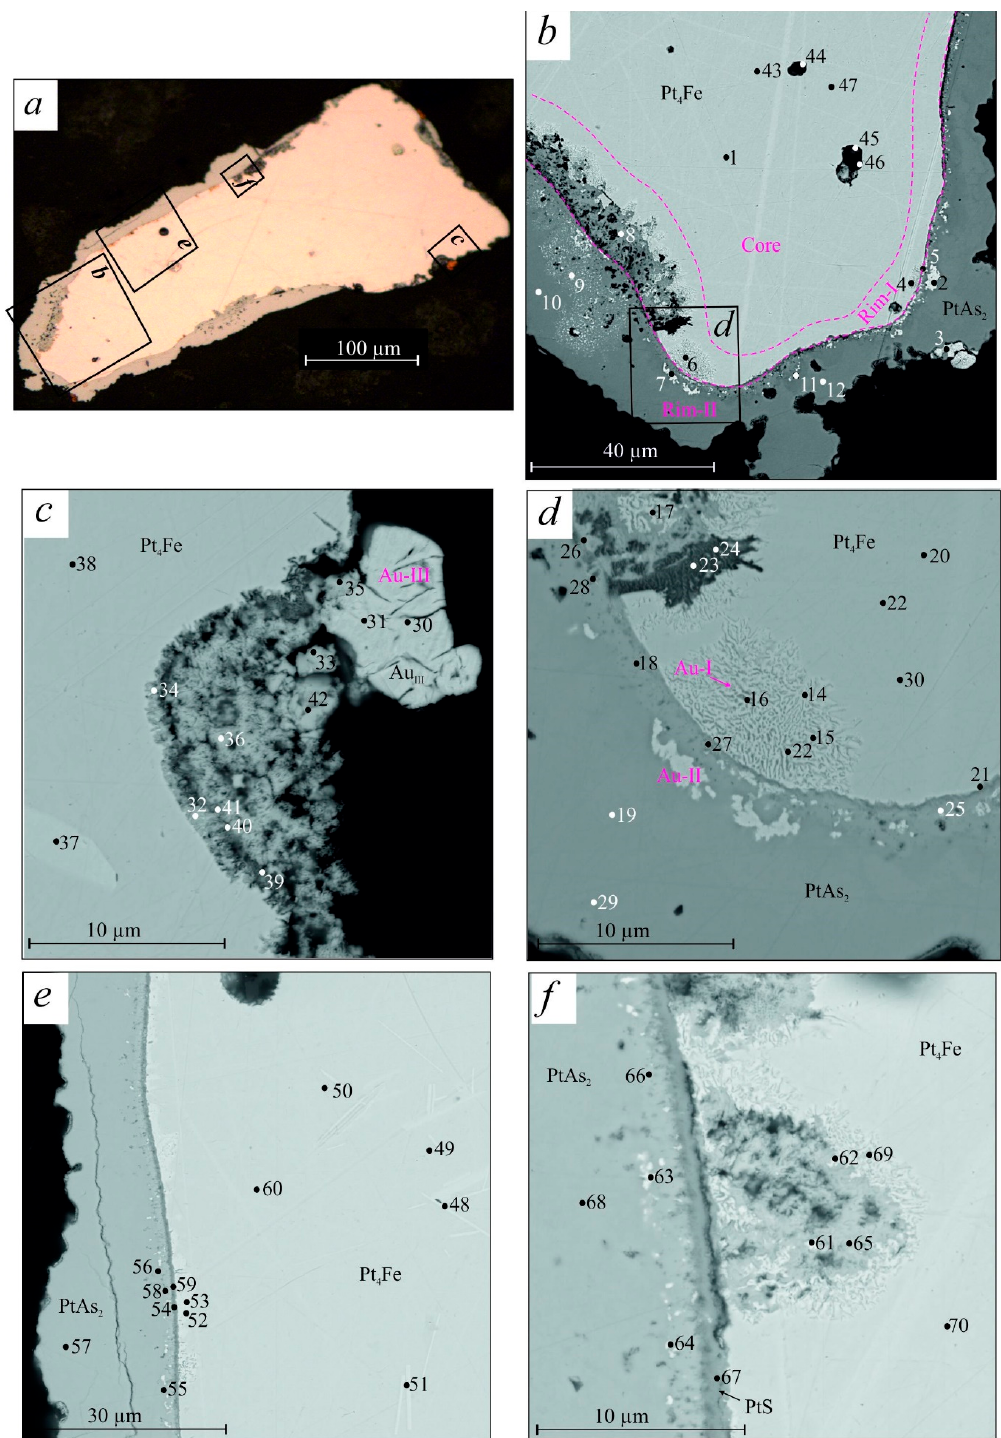
Figure 4. Grain No. 3 was derived from the placer of Kaurchak River (dredge 138). ( a ) Reflected light micrograph of grain No. 3 of the Pt-Fe alloy with alteration sperrylite composition rim (gray) and inclusions and overgrowths of native gold (reddish). ( b–f ) BSE images showing the structure and morphology of the local areas. Light gray background—matrix Pt 4 Fe; gray and dark gray rim—sperrylite and platarsite; white inclusions and overgrowths—native gold; the compositions of the Pt-Fe alloy and inclusions at these points are given in Tables 7 and